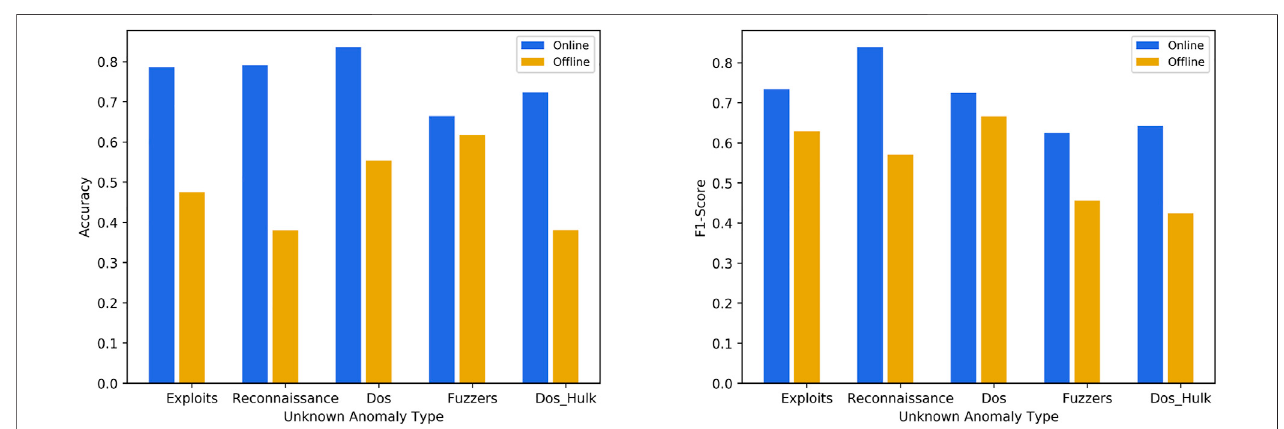
FIGURE 11 | The Accuracy and F 1 — Score performance of unknowns detection in the online mode and the of fl ine mode.